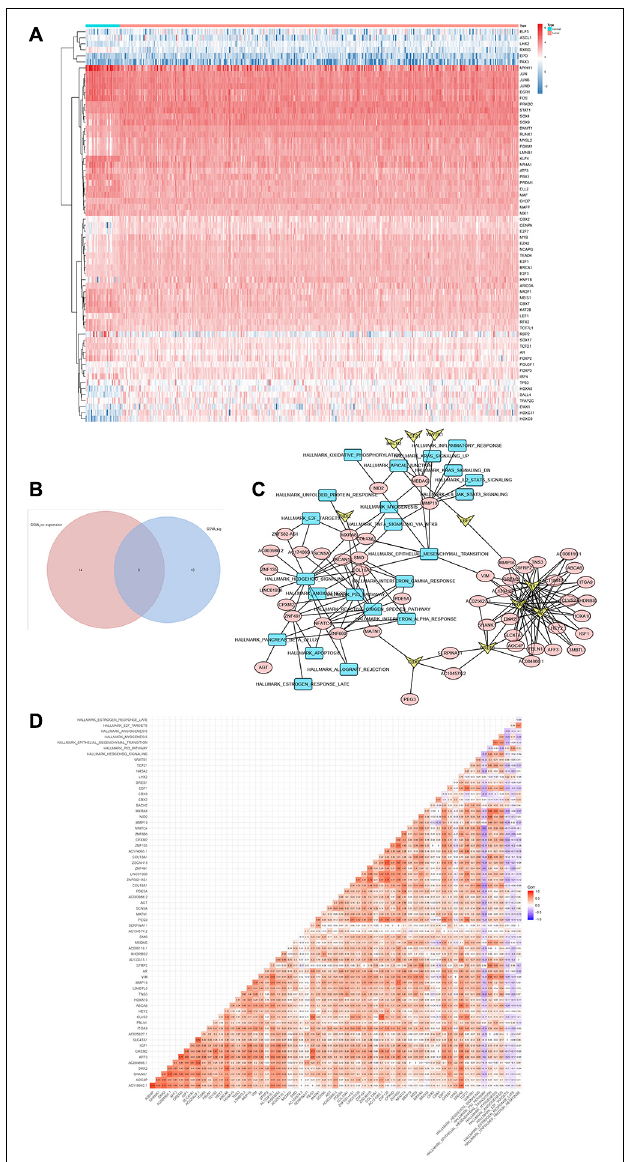
FIGURE 7 | Heat map showing the expression level of 65 differential expressed transcriptional factors (TFs) between 10 metastatic and 116 non-metastatic patients with CESC (A) . Venn plot for hallmarks of cancer via GSVA. Eight downstream mechanism were extracted from the intersection (B) . Regulatory network of TFs, DESRGs, and hallmark signaling pathways. Arrows represented TFs. Ellipses represented DESRGs. Rectangles represented hallmark signaling pathways (C) . Heat map for the correlation analysis (Pearson analysis) of DESRGs, TFs, and hallmark signaling pathways (D)